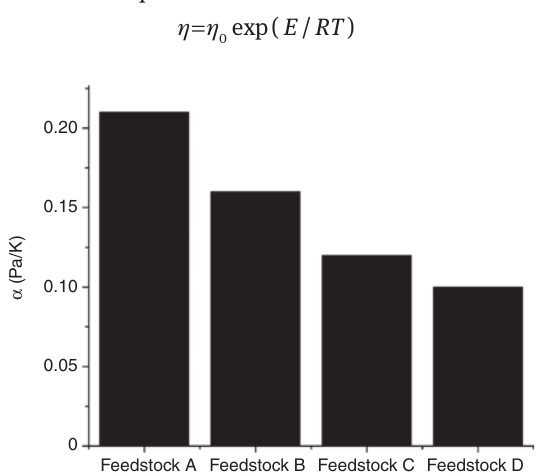
Figure 5 Evaluation of alpha values to determine the optimal powder loading.